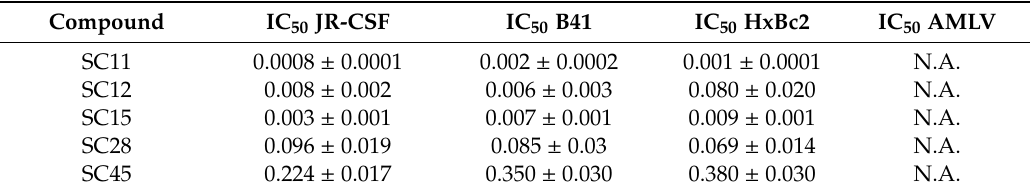
Table 3. Specificity and potency (in μ M) of SC compounds against HIV ‐ 1J R ‐ CSF, HIV ‐ 1 B41, HIV ‐ 1